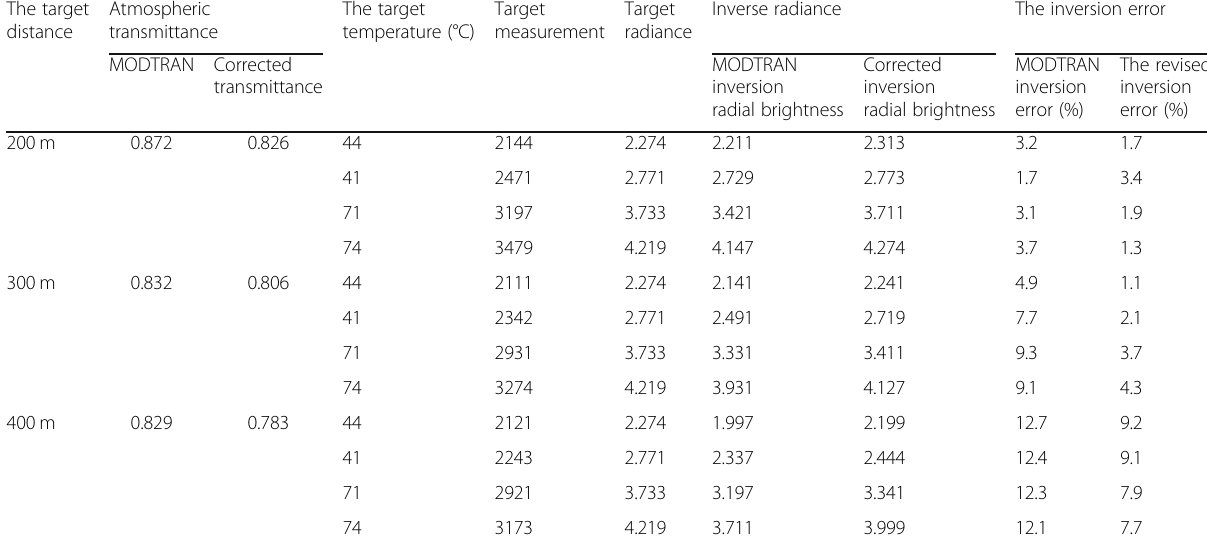
Table 7 Inversion results of atmospheric transmittance after modification when IT = 0.5 ms The target Atmospheric distance transmittance